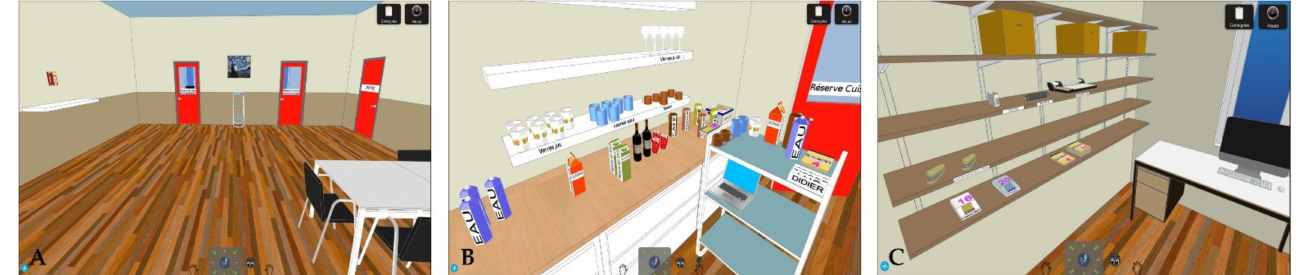
Figure 2. Sample pictures presenting the main room, person-avatar, and office material area from the Computerized Meeting Preparation Task (CMPT) [119]. Reprinted with permission from [119]. Copyright 2014 Elsevier. Participant‘s first person view: ( A ) in the main room where the meeting takes place, ( B ) in the kitchen, and ( C ) in the office material area.